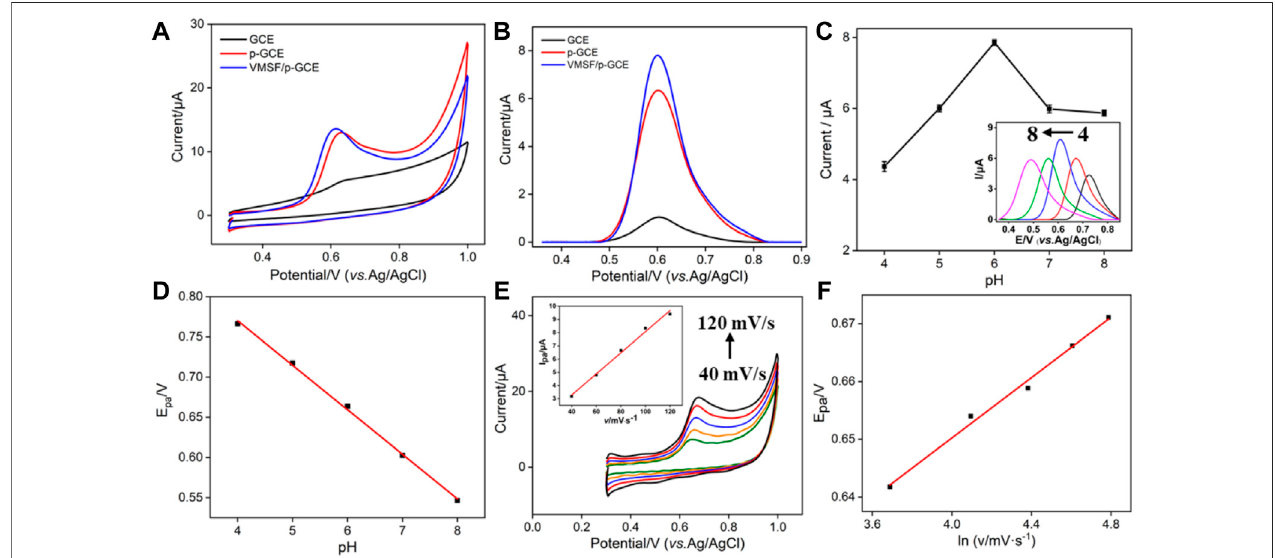
FIGURE 3 | CV (A) and DPV (B) curves obtained on GCE, p-GCE, and VMSF/p-GCE in PBS (0.1 M, pH = 6) containing BPA (10 μ M). The dependence of DPV anodic peak current (C) and CV anodic peak potential (D) on the pH value. Inset in c is the corresponding DPV curves in BPA (10 μ M). (E) CV curves of BPA (10 μ M) on the VMSF/p-GCE with different scan rates (40, 70, 100, 130, 160, 190, and 220 mV/s). The inset is the plot of the scan rate vs. peak current. (F) Dependence of E pa on the natural logarithm of scan